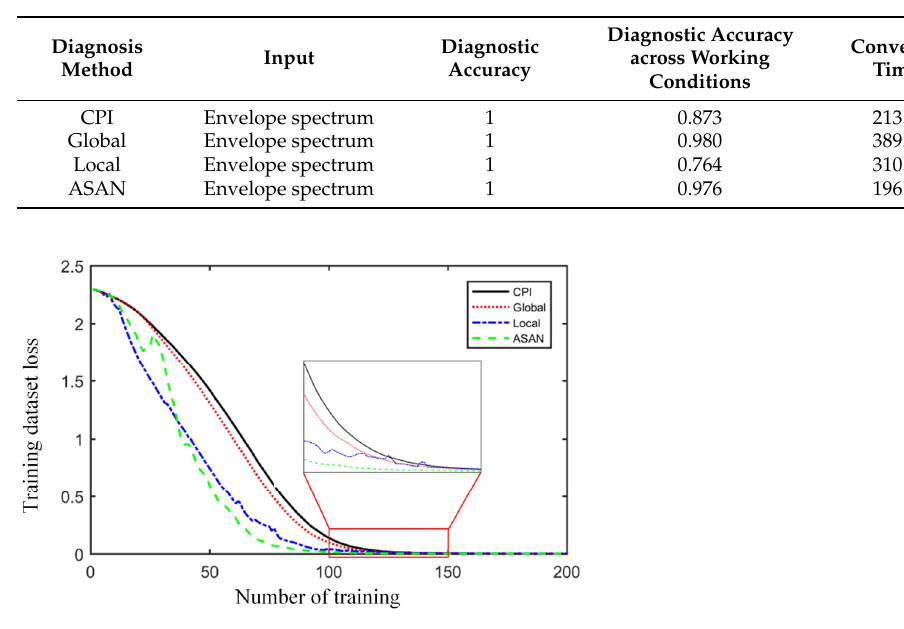
Figure 8. Loss trend graph of the training set.